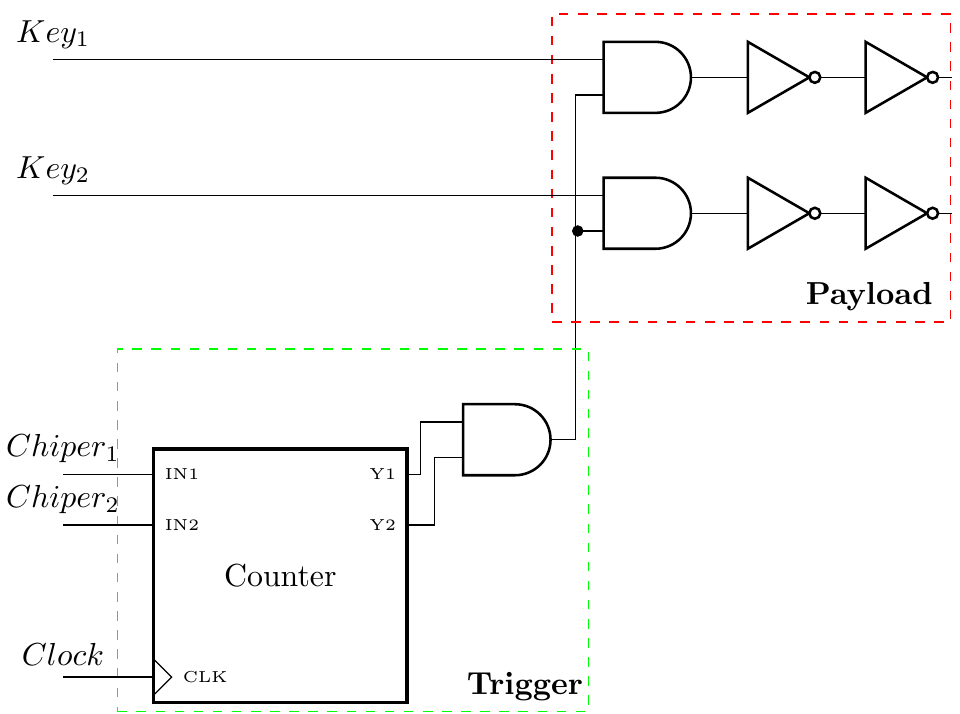
Figure 1. Sequential Trojan circuit